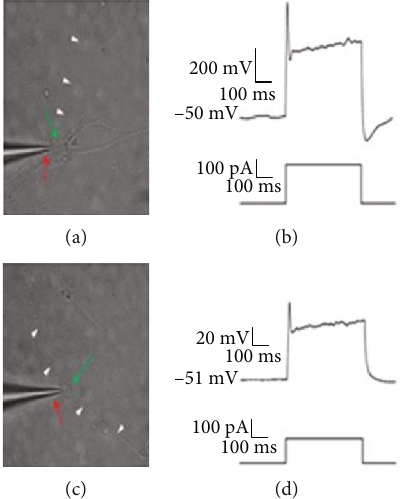
Figure 2: Patch-clamp analysis of electrophysiological properties was performed on neuron. (a) Patched neuron, red arrow indicates the patch pipette while the patched cell is by the green arrow. White triangles indicate the processes of the patched cell. (b) An action potential (upper trace) is elicited by depolarizing current stimulation (pulse duration: 500ms, range: -10-300pA, increment: 10pA). (c) Patched cholinergic neuron with red arrows indicating pipette and green arrow pointing at patched cell. White arrows indicate processes of the patched neuron. (d) Action potential elicited from the patched cholinergic neuron using the same settings as for neurons in (b).